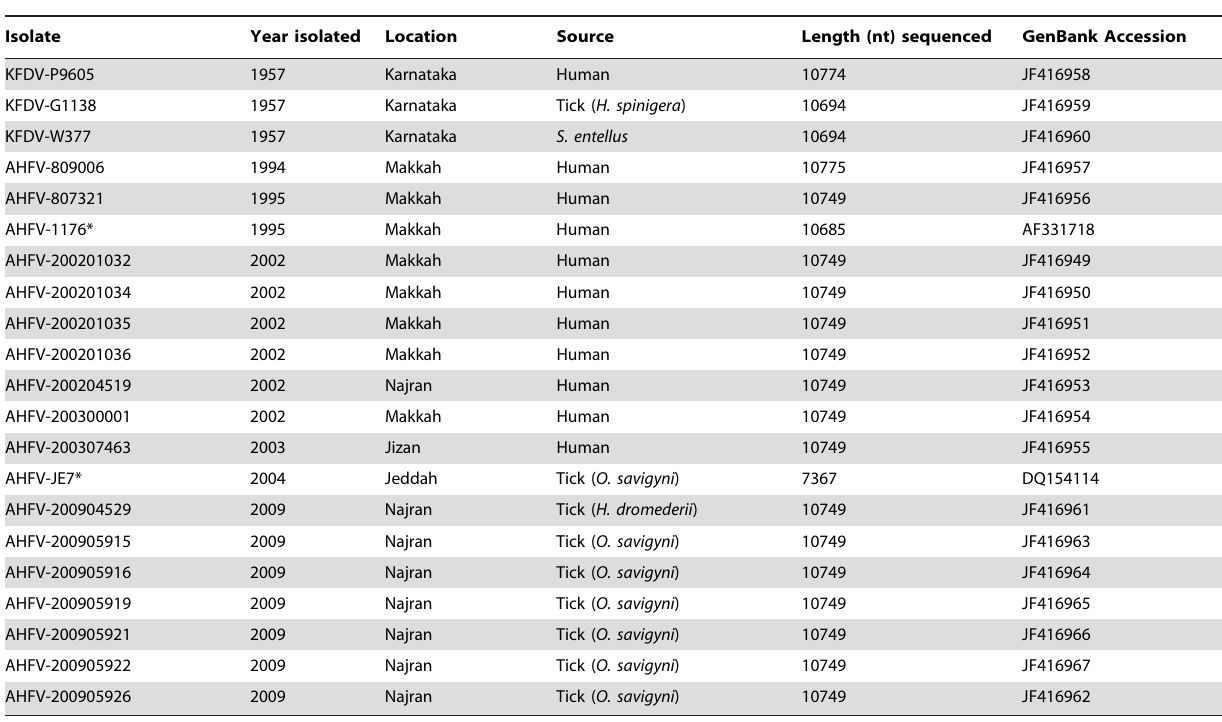
Table 1. AHFV and KFDV isolates included in analysis.